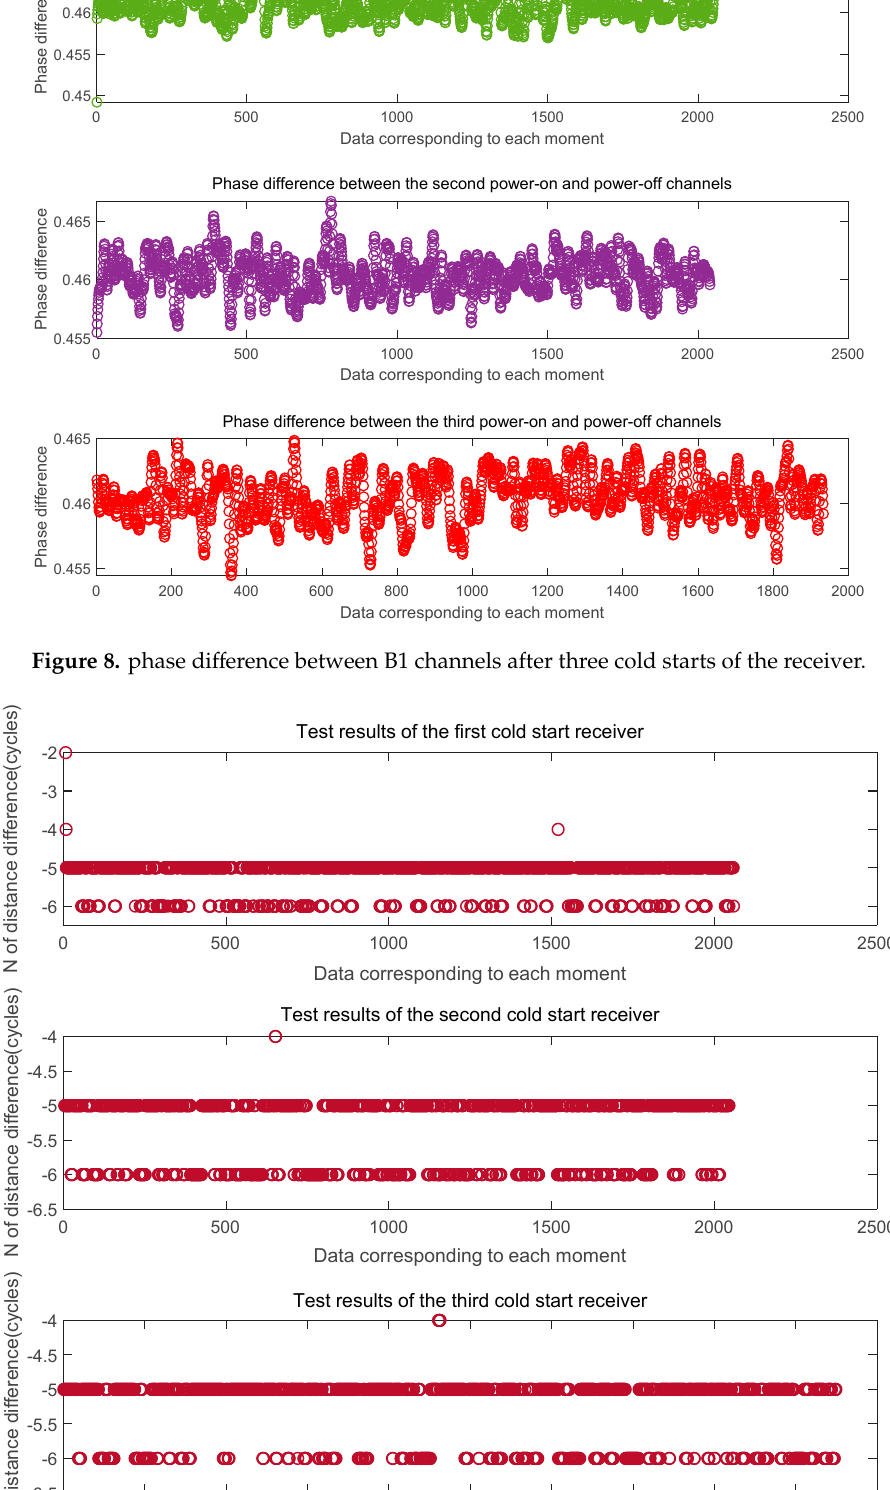
Figure 7. Phase difference between L1 channels after three cold starts of the receiver.